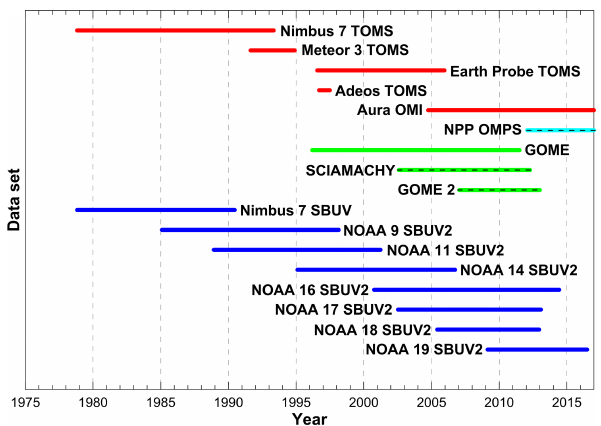
Figure 1. A graphical representation of the different satellite-based data sets used in this study and their periods of coverage. Satellites marked with a dashed line indicate newly added source data for this version of the